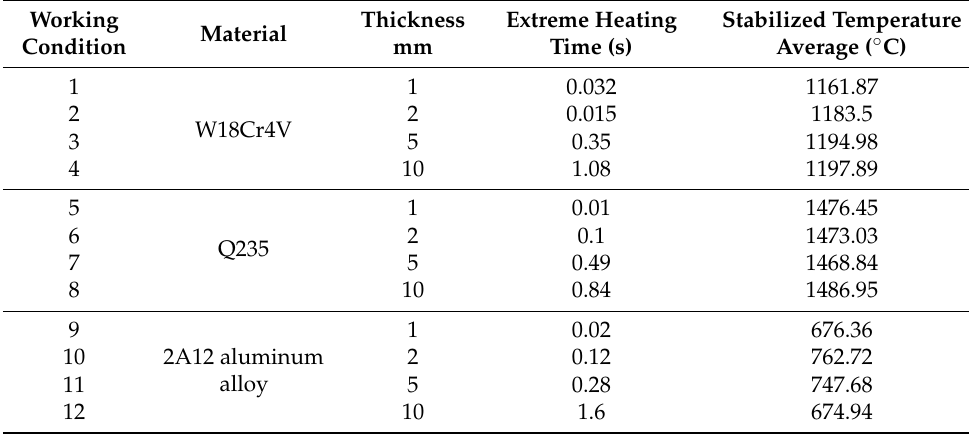
Figure 8. The curve of the maximum temperature at the W18Cr4V slit with time. Table 3. Results of the temperature analysis for different working